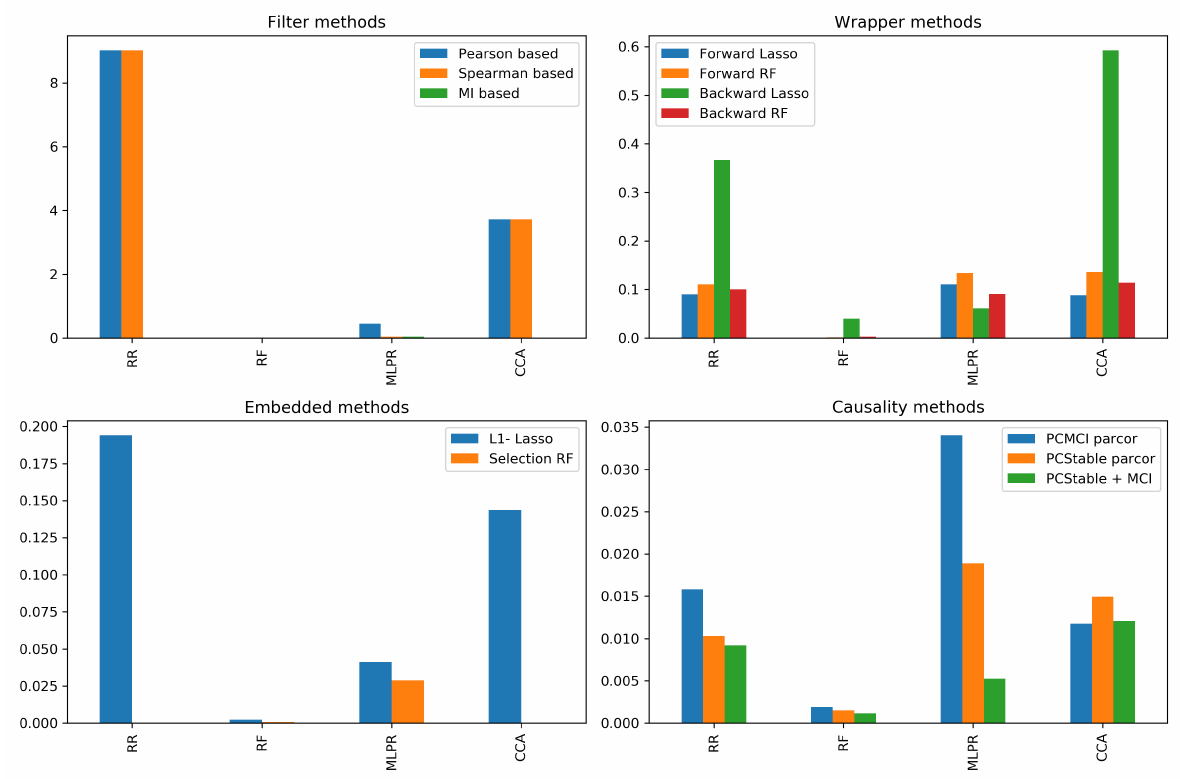
Figure 8. MAE in validation set considering all variable selection methods applied in Fault